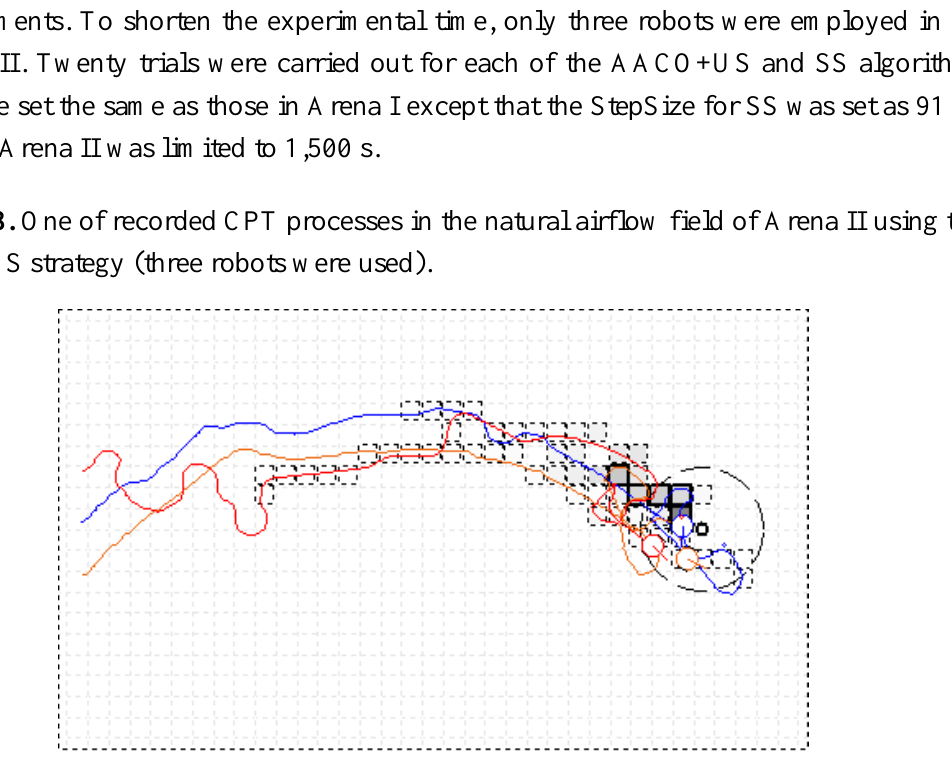
Figure 19. DR for real-robot experiments using the AACO+US and the SS algorithms in n Arena